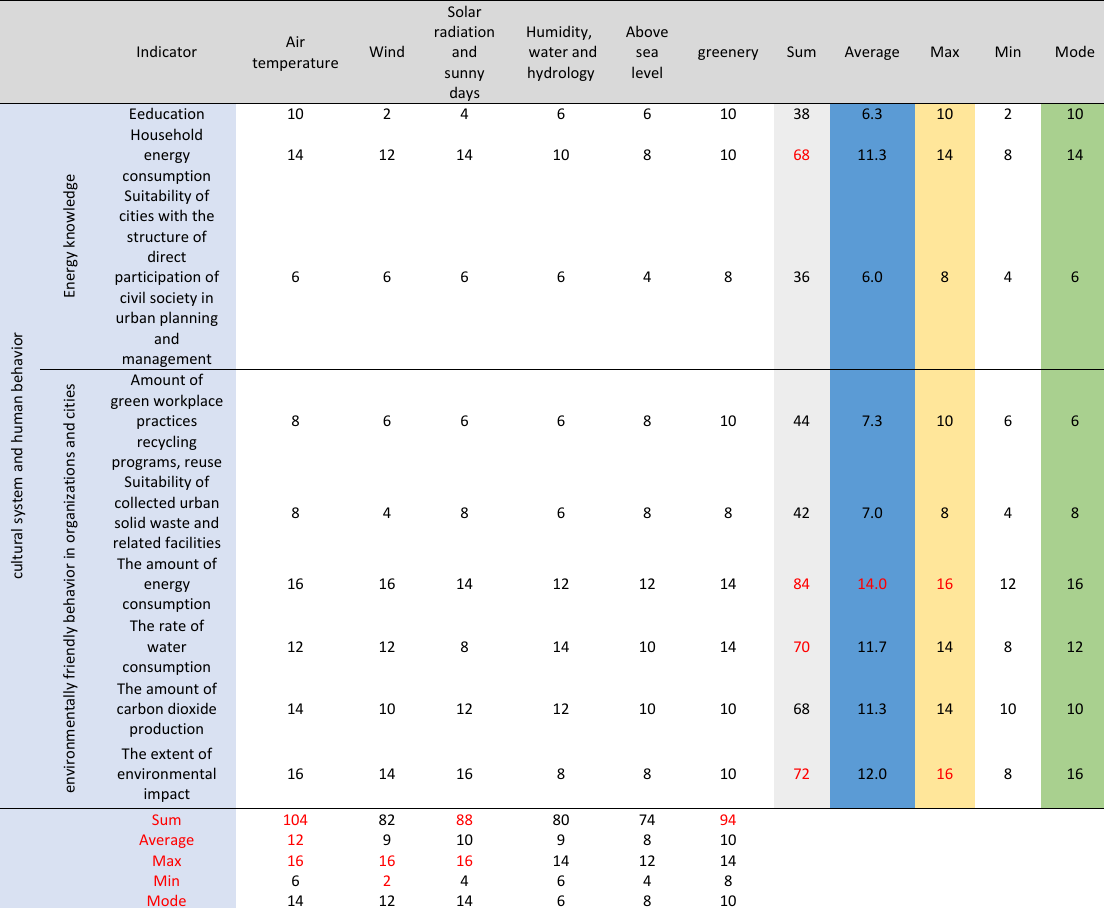
Table 9: Relation between cultural system and climate